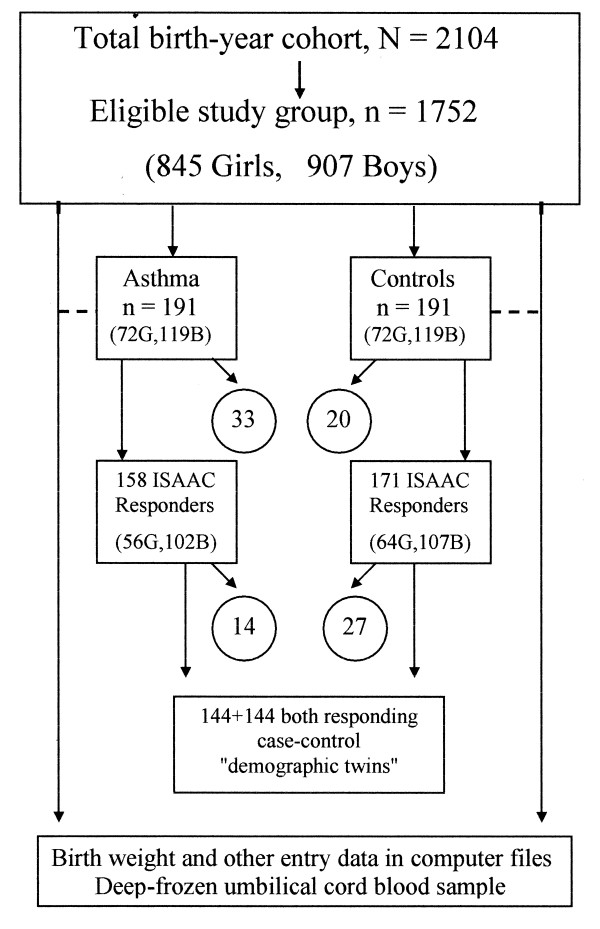
Participants in the study.